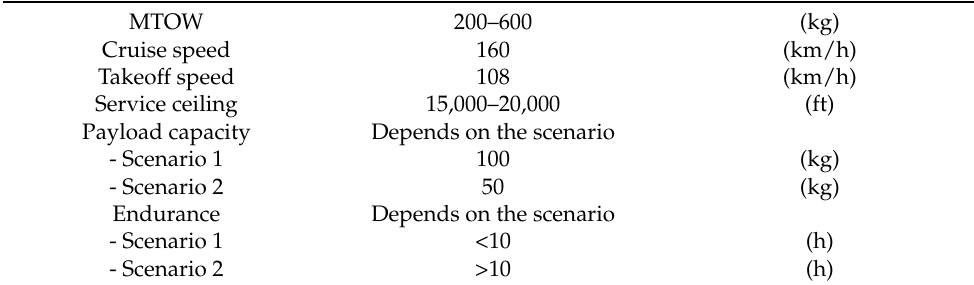
Figure 2. External layout of the tactical Blended-Wing-Body (BWB) Unmanned Aerial Vehicle (UAV), reference platform [8]. Table 1. Reference BWB UAV platform specifications.